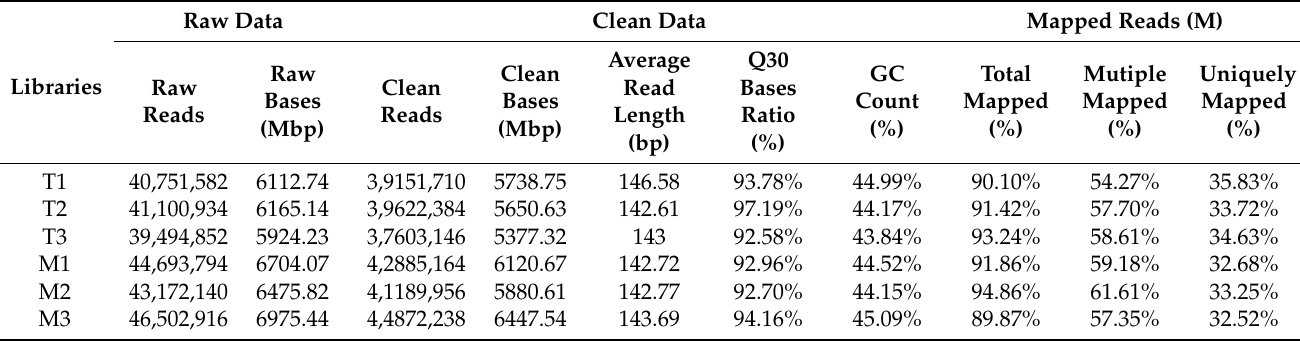
Table 1. Data quality of RNA-Seq and mapping